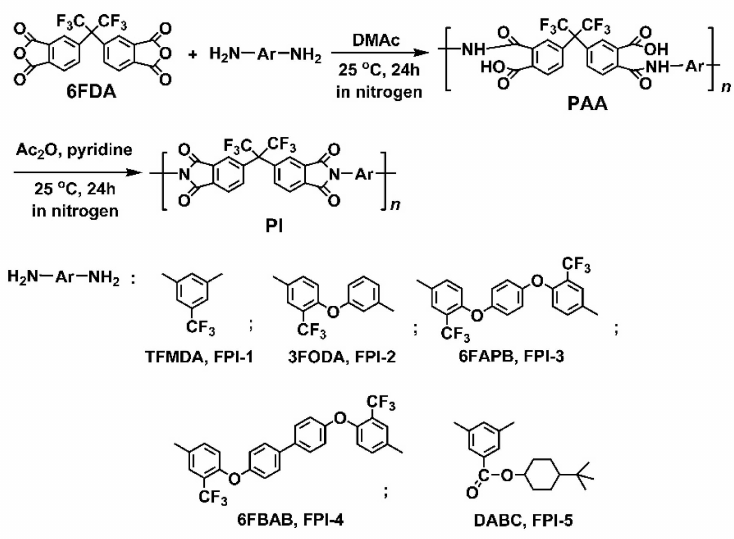
Figure 2. Preparation of fluoro-containing PI resins. Table 1. Inherent viscosities, molecular weights, and solubility of FPI